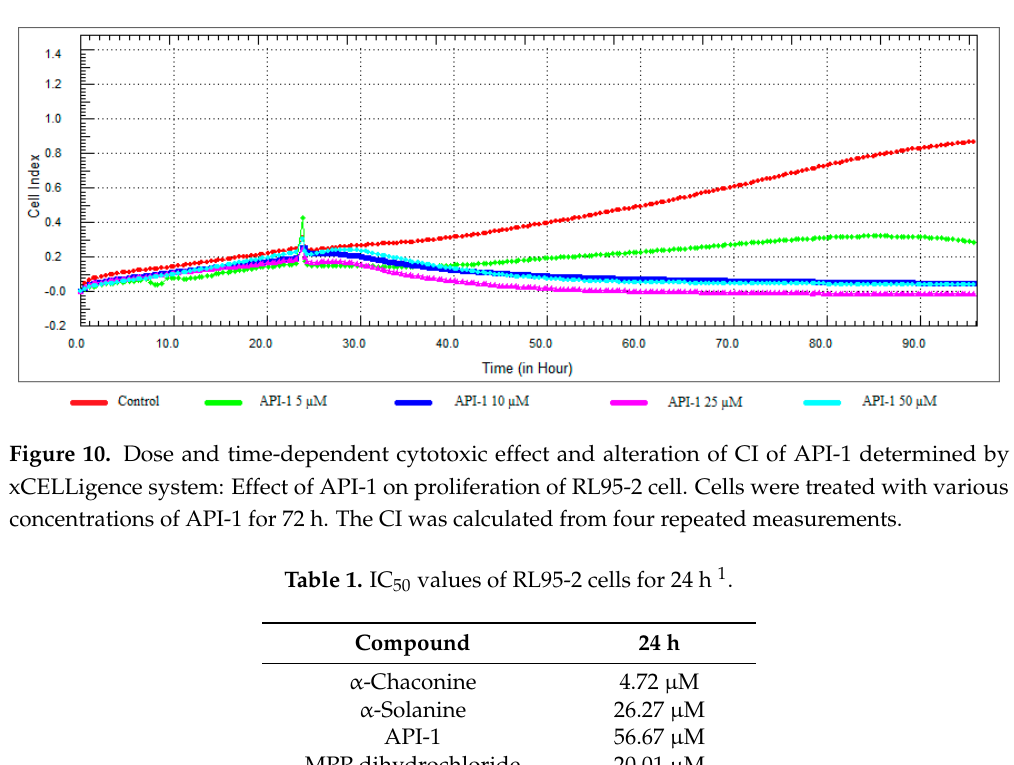
Figure 9. Dose and time-dependent cytotoxic effect and alteration of CI of MPP dihydrochloride determined by xCELLigence system: Effect of MPP dihydrochloride on proliferation of RL95-2 cell. Cells were treated with various concentrations of MPP dihydrochloride for 72 h. The CI was calculated from four repeated measurements.